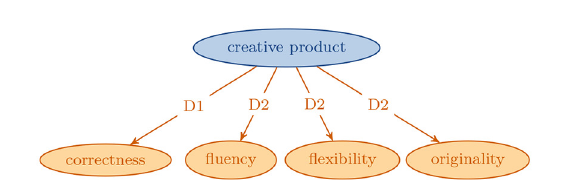
FIGURE5 A closer look at the product plate. It describes the creativity of a product in terms of correctness, fluency, flexibility, and originality. Citations: D1 (Runco and Jaeger, 2012), D2 (Torrance, 1972; Huang et al., 2010; Muldner and